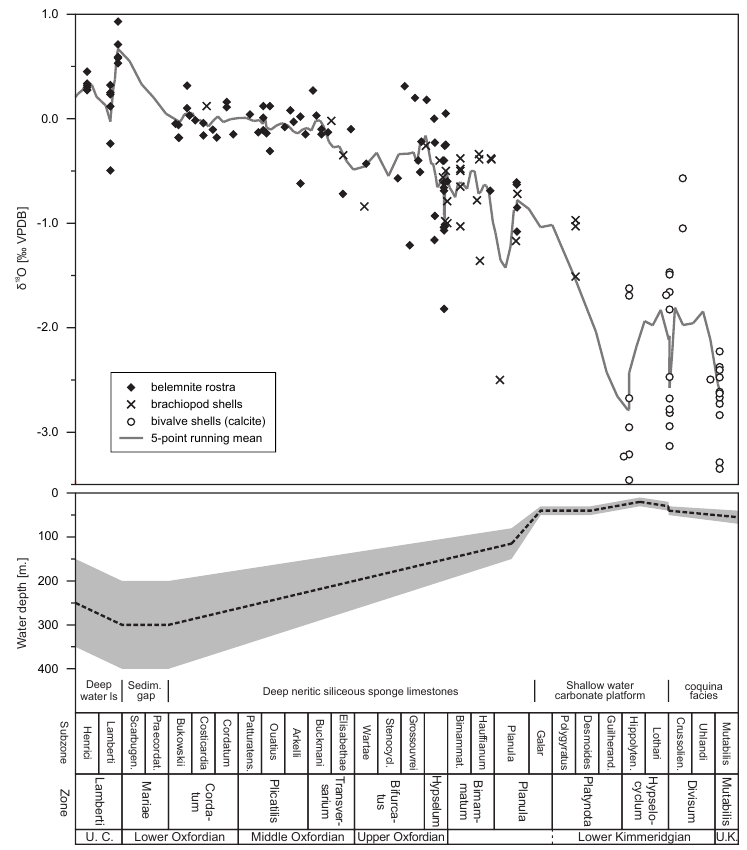
Figure 12. δ 18 O record of uppermost Callovian–mid-Kimmeridgian (Middle–Upper Jurassic) belem- nite rostra and brachiopod and bivalve (oyster, Trichites ) shells (after Wierzbowski [58,79,108] and Wierzbowski et al. [304]) along with palaeobathymetry and sedimentary changes in the mid-Polish basin (the Polish Jura Chain and the SW margin of the Holy Cross Mountains; after Matyja nad Wierzbowski [305], Pisera [306], Wierzbowski et al. [307], Wierzbowski et al. [304], Matyja [308] and Wierzbowski [79,309,310]. The temporal oxygen isotope record is significantly affected by bathymetry variations, which induced a gradual increase in bottom temperatures and palaeocirculation and palaeogeography of the basin, which were responsible for salinity variations. A rapid salinity decrease likely occurred in the